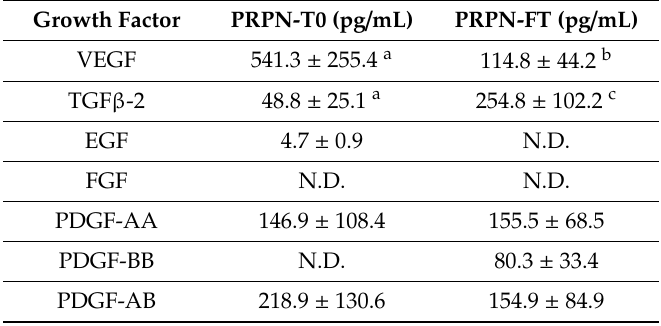
Table 1. Concentration of growth factors (pg / mL) in fresh not-activated PRP samples (PRPN-T0) and not-activated PRP samples frozen-thawed